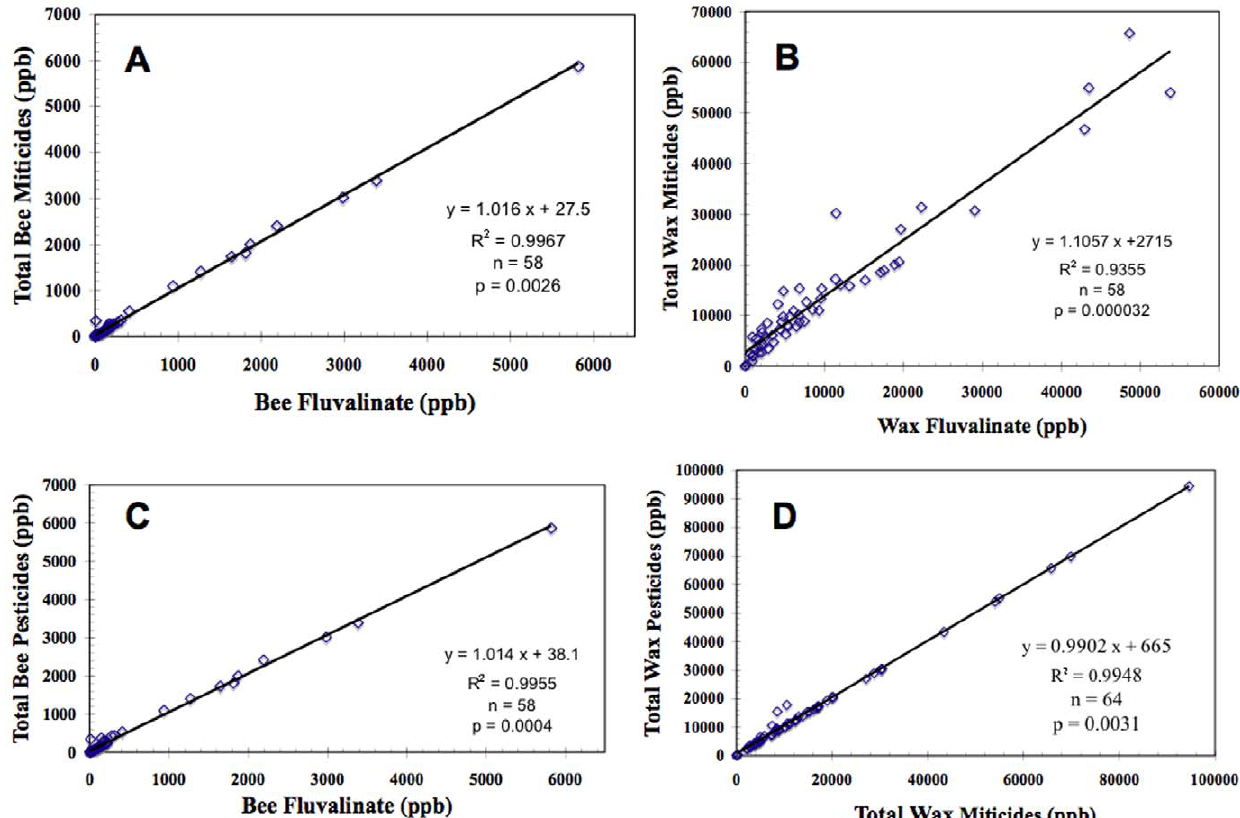
Figure 1. Correlations of bee and wax fluvalinate residues (ppb) with total miticide and pesticide contents in paired colony samples. Regressions of bee fluvalinate with total miticides (A), wax fluvalinate with total miticides (B), bee fluvalinate with total pesticides (C), and of wax miticides with total pesticides (D). doi:10.1371/journal.pone.0009754.g001 PLoS ONE |